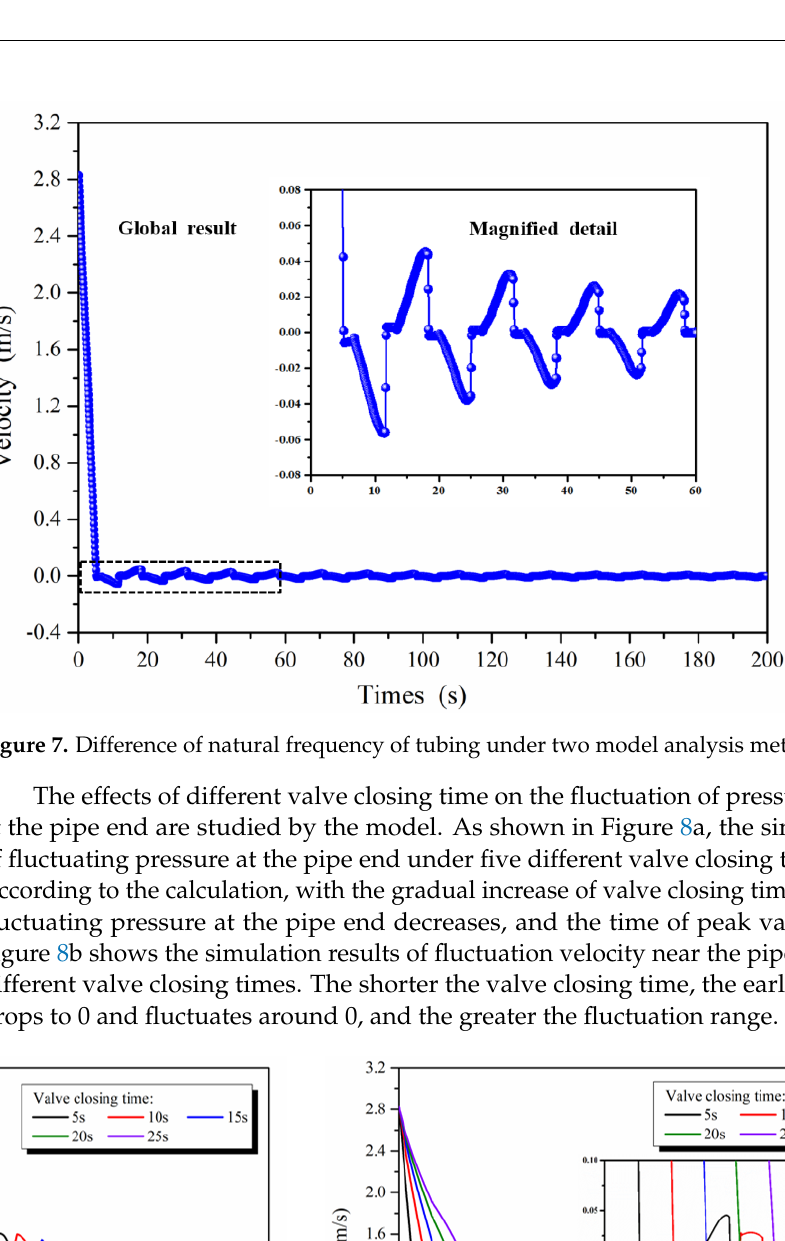
Figure 6. Pressure fluctuation at the end of the pipeline.